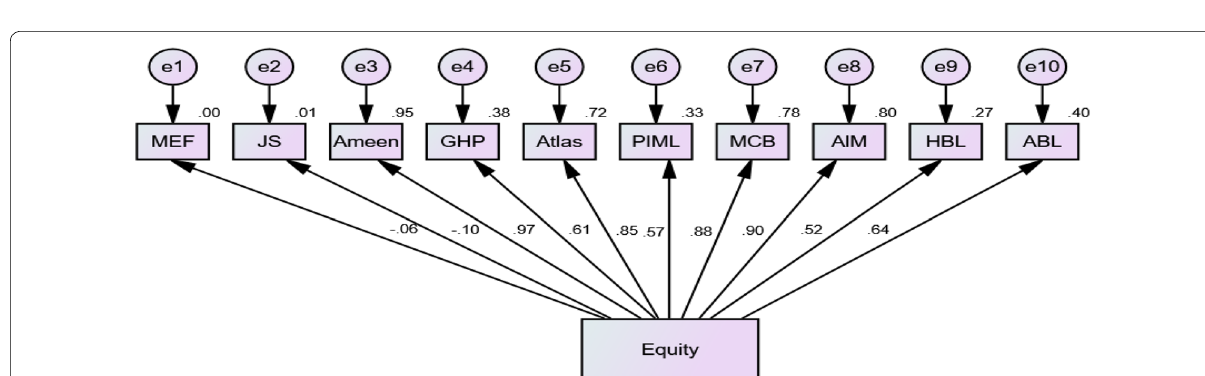
Fig. 4 Islamic equity funds of Pakistan. The path terms used in the diagram are: MEF Ameen Shari‘ah stock fund; GHP Islamic Stock Fund; ALM